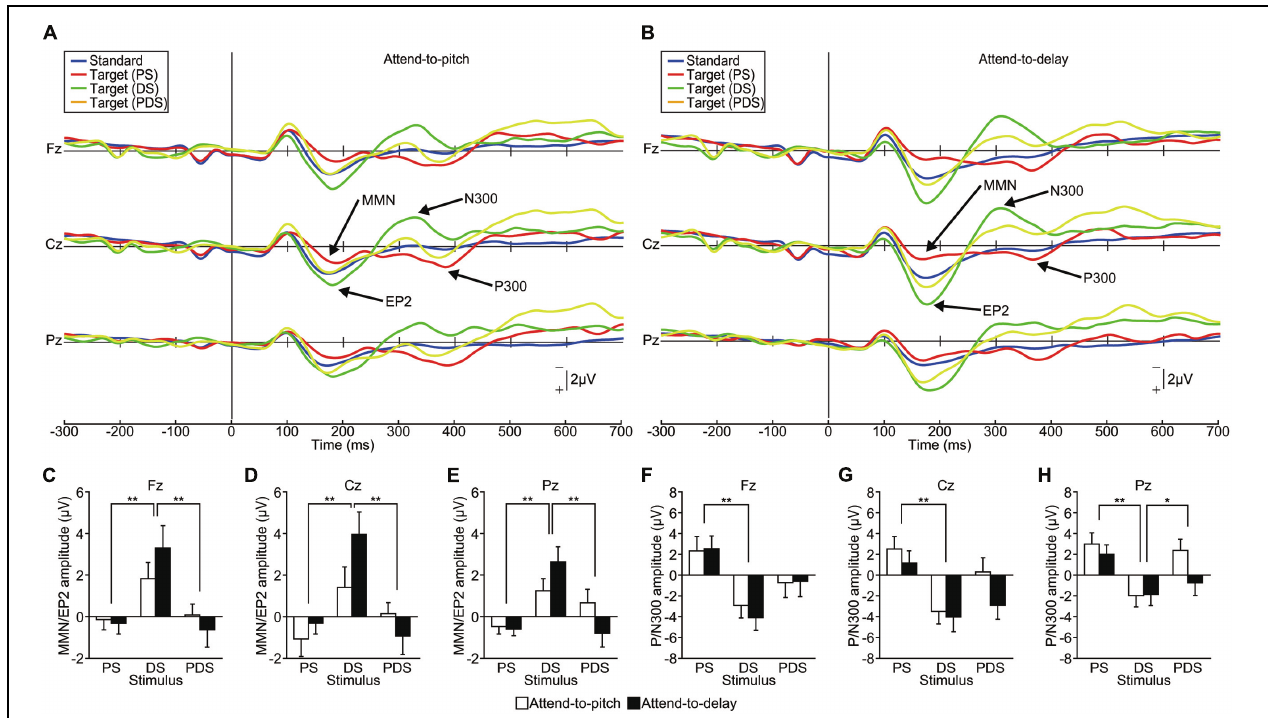
FIGURE 4 | Functional dissociation between the EP2/N300 and MMN/P300 (Experiment 3). (A,B) Grand-averaged ERP waveforms elicited by pitch-deviant (PS), delayed (DS), and pitch-deviant delayed (PDS) feedback (action conditions only, n = 16). The participant was instructed to attend to either (A) pitch-deviant (PS and PDS) or (B) delayed (DS and PDS) auditory feedback. (C–H) The amplitude of the MMN/EP2 and P/N300 at each electrode. (C–E) Two-way repeated-measures ANOVAs examining the amplitude of the MMN/EP2 revealed a significant main effect of the type of feedback [Fz: F ( 1 , 90 ) = 9.14, p < 0.01, effect size η 2 = 0.17; Cz: F ( 1 , 90 ) = 9.31, p < 0.001, effect size η 2 = 0.17; Pz: F ( 1 , 90 ) = 10.08, p < 0.001, effect size η 2 = 0.18] but no main effect of selective attention ( p > 0.3). A post hoc analysis (Tukey’s HSD test) revealed significant differences between PS and DS and between DS and PDS at all electrodes ( p < 0.01).